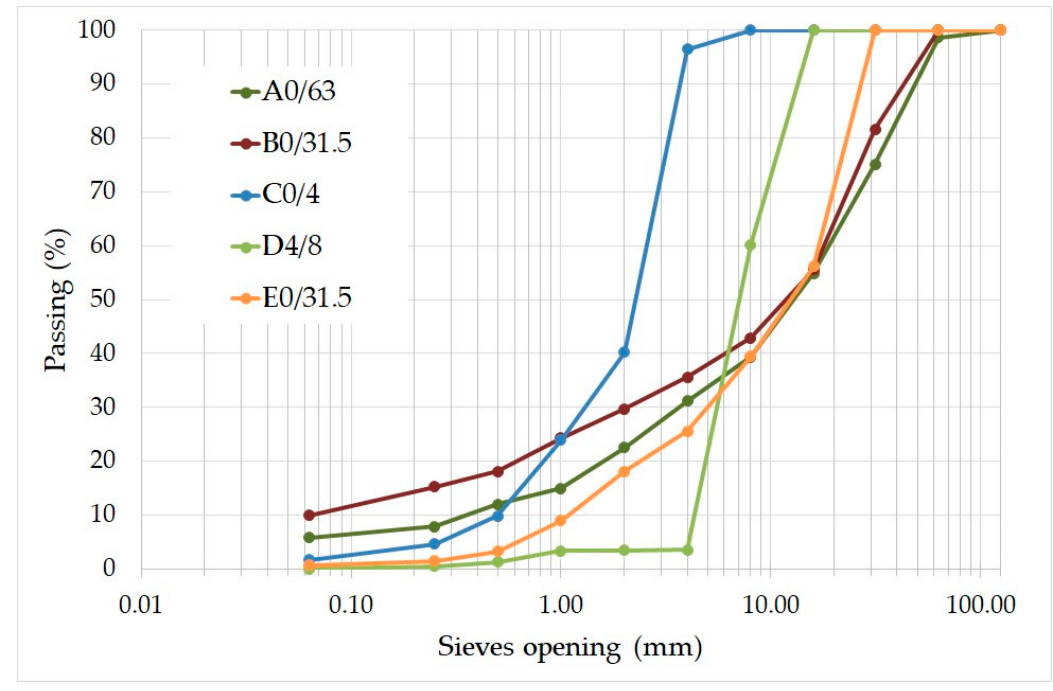
Figure 1. Particle size distribution of base materials. Table 1. Results of leaching tests on base materials.